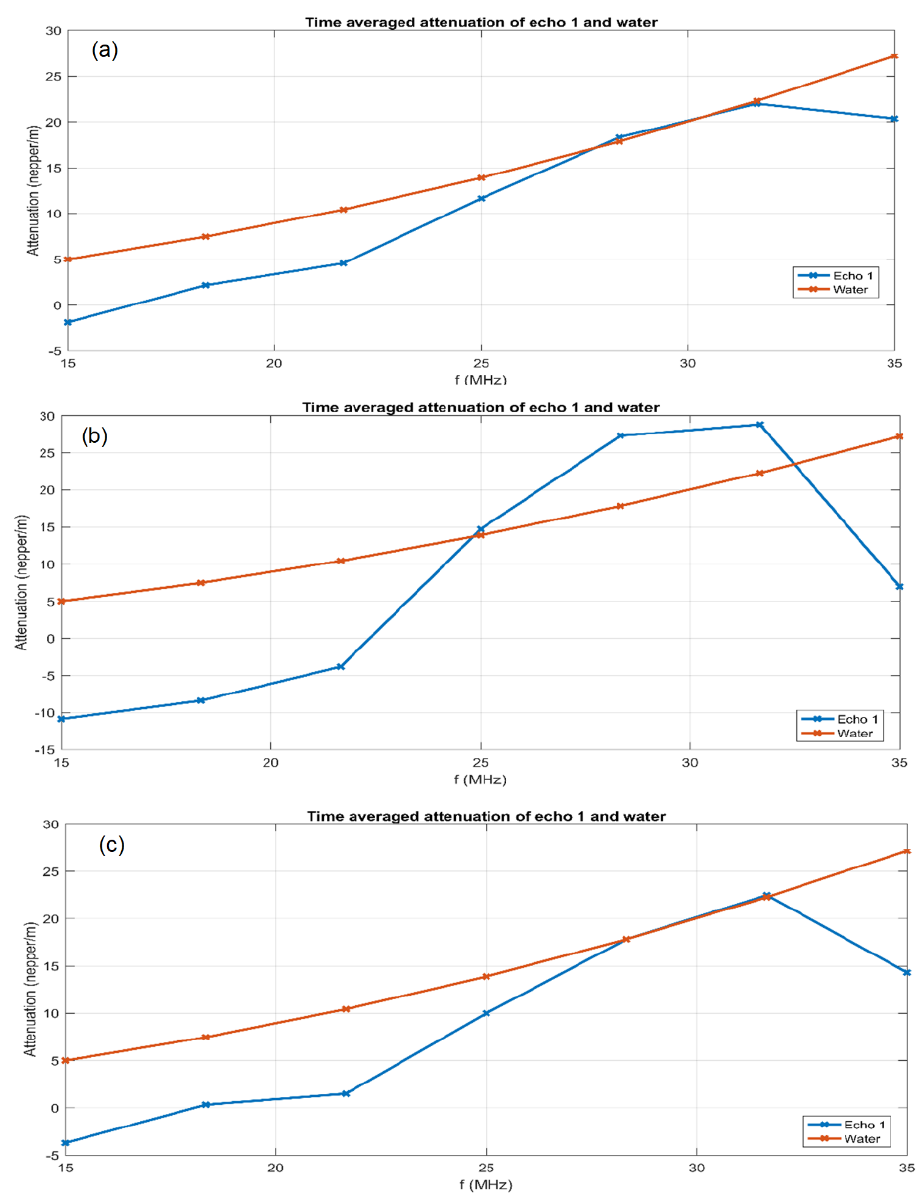
Figure 6. Attenuation of ultrasonic signals vs. frequency for the three samples AgHA ( a ), AgHA-C ( b ), and AgHA-T ( c ).